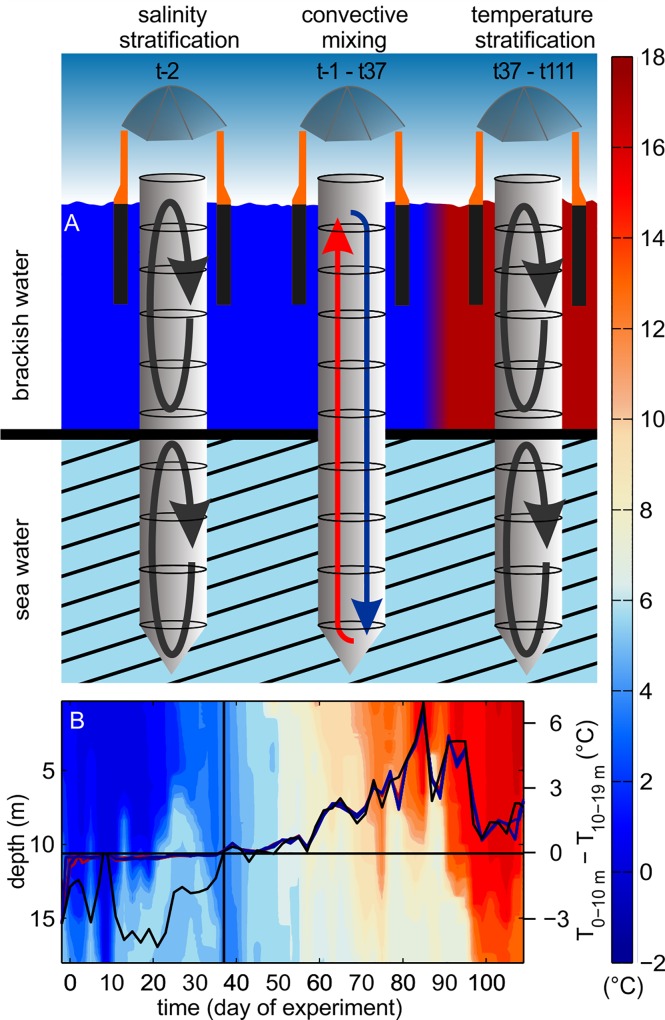
Changes in water column mixing in the course of the experiment.A salinity stratification prevented water column mixing at the beginning of the study (t-2). Convective mixing was initiated after homogenizing water column salinity. Convection was sustained until t37 by saline North Sea water which was warmer than the fresher surface water. (B) Surface water temperature rose above that of the deep water after t37 thereby establishing temperature stratification and terminating convective mixing.